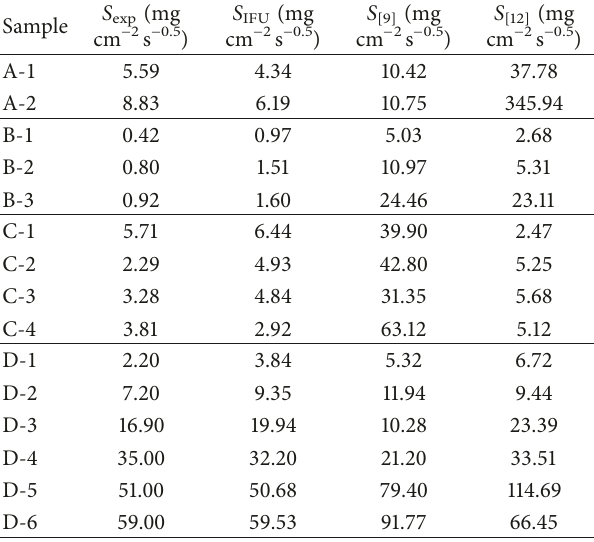
Table 5: Comparison among the sorptivity values obtained ex- perimentally ( S exp ), calculated on the basis of the IFU model ( S IFU ) and the formulas proposed by Raimondo ( S [9] ) and Scherer ( S [12] ). S exp (mg Sample cm − 2 s − 0.5